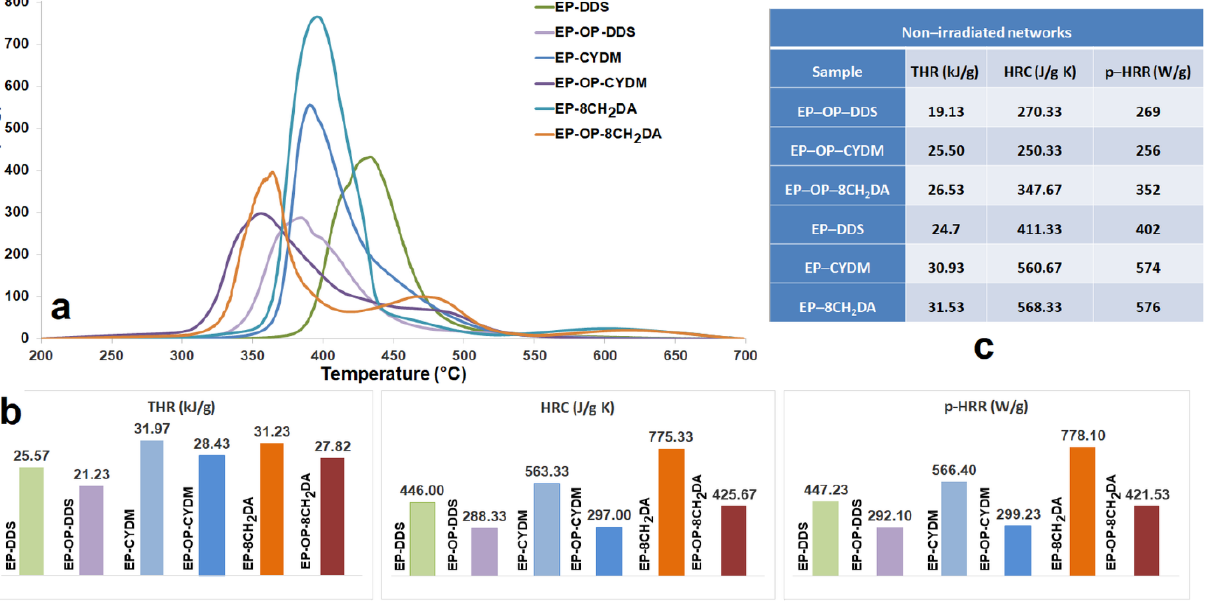
Figure 11. ( a ) HRR and ( b ) MCC data of UV irradiated samples; ( c ) table of MCC data of